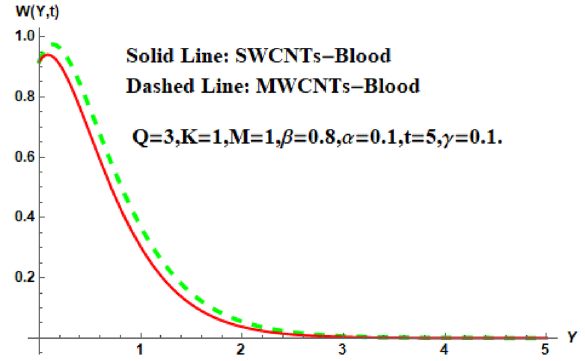
Figure 14. Analysis of SWCNTs and MWCNTs on W ( Y , t )